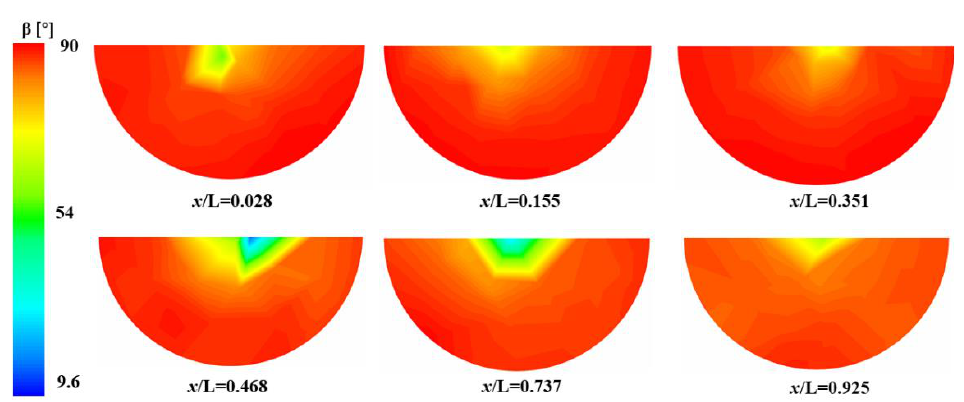
Figure 22. The variation in the synergy angle in different axial